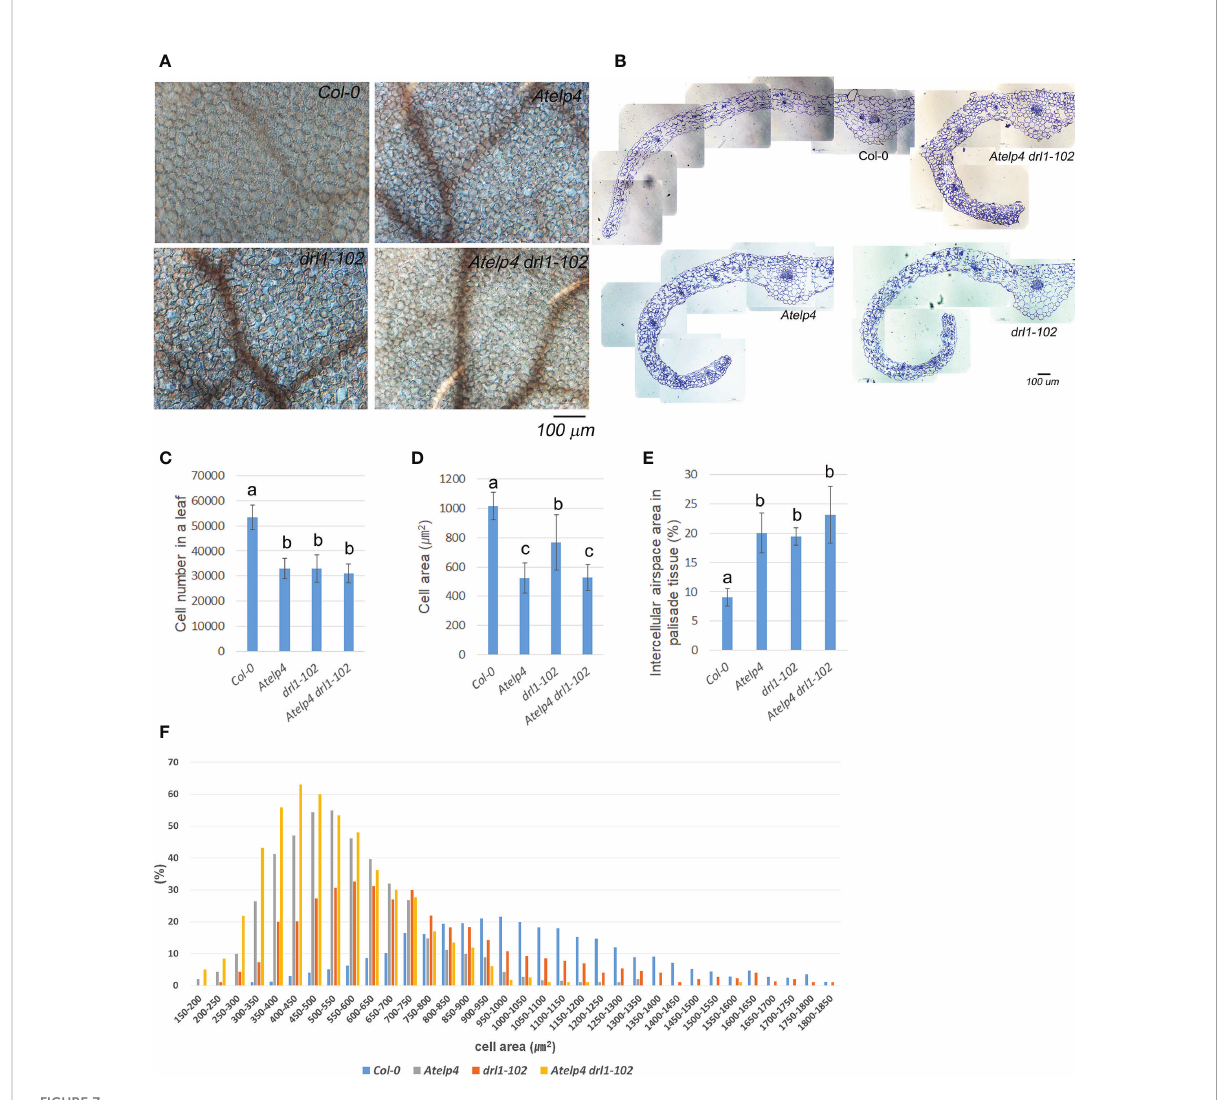
FIGURE 7 Internal morphology in leaves and statistical analysis of palisade cells from Atelp4 and drl1-102 single and double mutants. (A) Paradermal images of palisade cells in the mature third rosette leaves in wild type, Atelp4 , drl1-102 , and Atelp4 drl1-102 on 21 DAS. (B) Transverse section of the middle region in the mature third leaves. Scale bar = 100 m m. (C) Cell number, (D) cell size, and (E) proportion of intercellular airspace in the mature third rosette leaves on 21 DAS. (F) Area distribution of palisade cells in the central region between leaf mid-vein and margin in the widest part of leaf blade. Leaves were independently collected from six plants, and data are shown as the means with SEs. Different lowercase letters in panels (C – E) indicate signi fi cant differences between plants, according to ANOVA and Tukey ’ s multiple range test (p-value